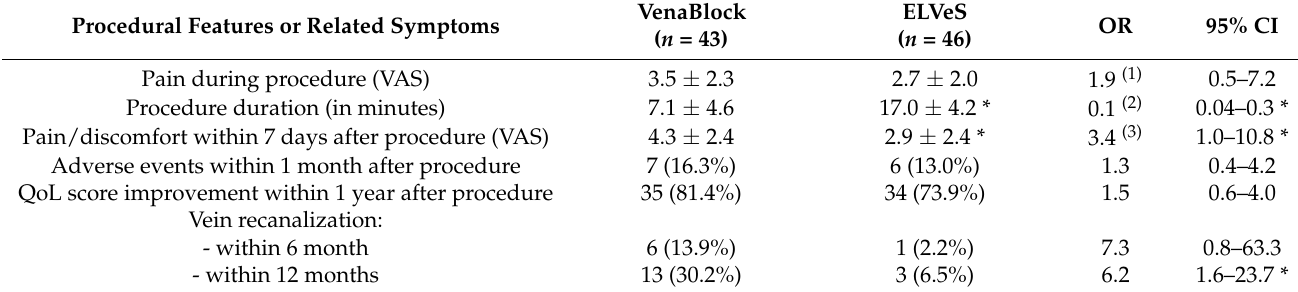
Table 2. Comparison of the results for both methods with regards to selected clinical features assessed in the ESVETIS study within 1 year after procedure. Values in the table represent the mean ± standard deviation, or patient number (percent) in the group, respectively. Statistically significant differences were marked with asterisks (* p <